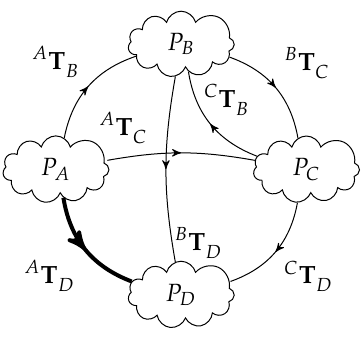
Figure 3. Rearrangement of example from Figure 2 of four distinct point clouds, but now showing all the paths for transformations from A to D, passing also through B and